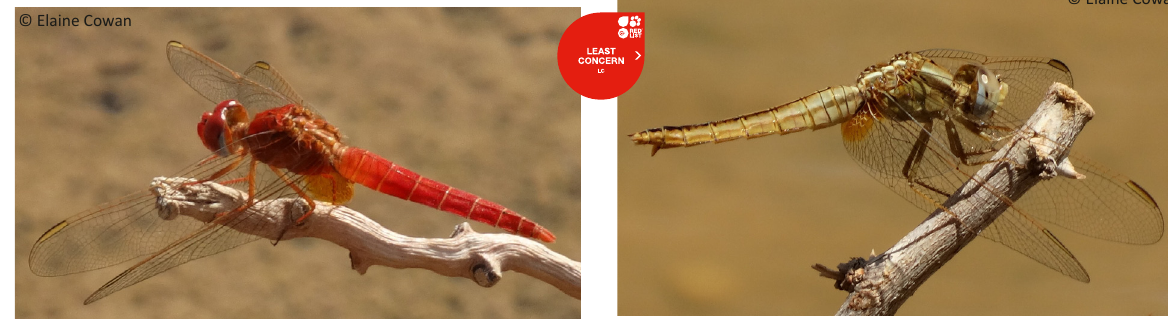
Image 16. Male Orthetrum sabina , 5 June 2014. Greenish eyes and striped thorax. Black and white abdomen terminally club-shaped with white terminal appendages